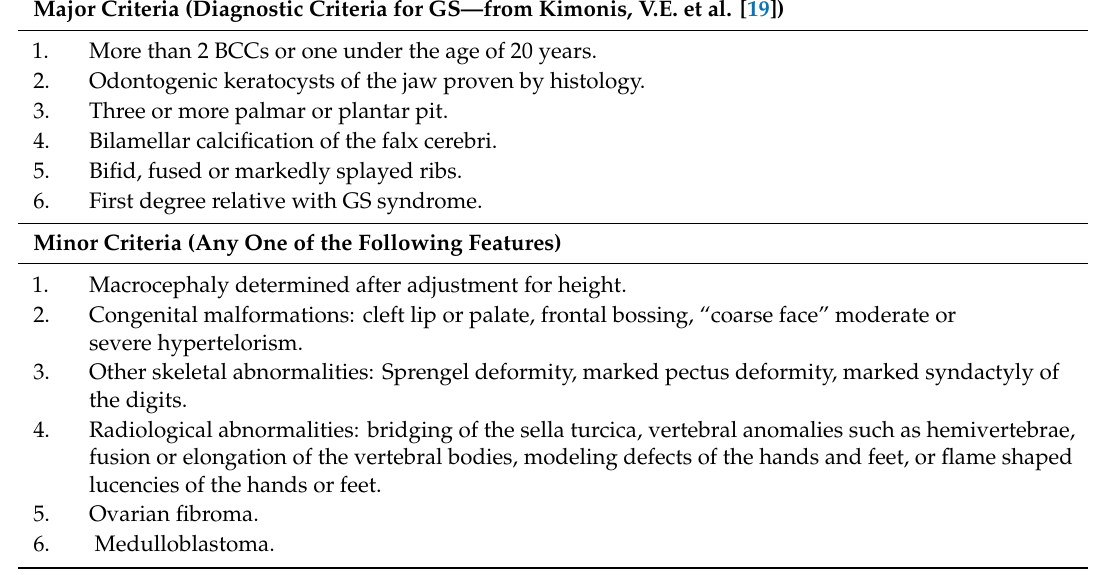
Table 1. Gorlin syndrome diagnostic